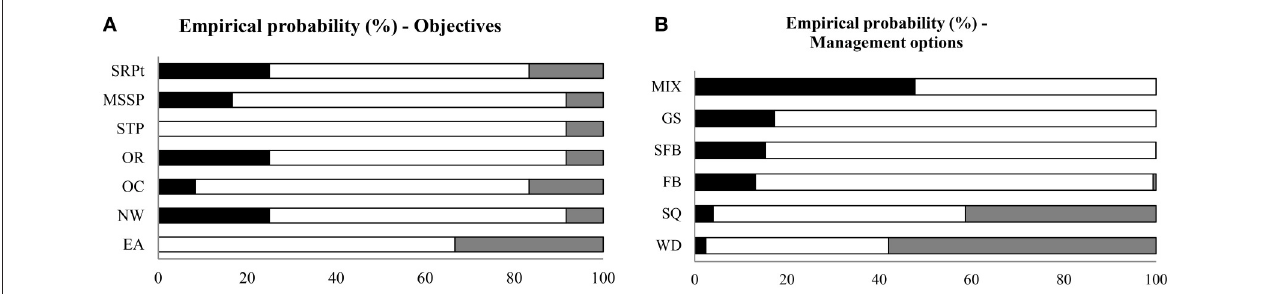
FIGURE 6 | Survey 2—NSFDSS (Exploratory analysis): empirical probability to be first and to be last associated to (A) objectives and (B) management options, according to stakeholders’ preferences, respectively, for ecological, economic, and social components. (A) SRPt, Maintain a safe level of the reproductive potential of target species; MSSP, Maintain a safe structure of spawner population; STP, Maintain an adequate structure of target populations; OR, Optimize revenue; OC, Optimize costs; NW, Maintain occupation levels; EA, Allow equitable access to resources by all the fishing metiers. (B) MIX, measures combination; GS,